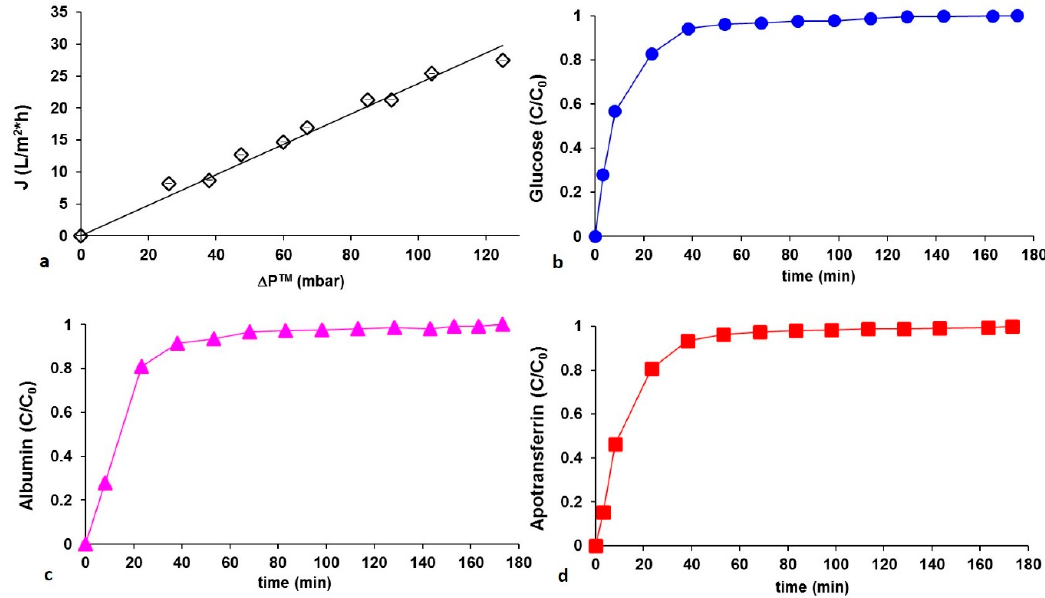
Figure 3. ( a ) Hydraulic permeation measurements of PCL HF membranes at different transmembrane pressures ∆ P ™ . Experimental values were averaged on 10 measurements; the interpolation of experimental data is reported as a solid line: slope (hydraulic permeance): 0.238 L / m 2 · h mbar; R-squared value: 0.98. Concentration appearance profiles of ( b ) glucose, ( c ) albumin, and ( d ) apotransferrin permeating PCL HF membranes at constant transmembrane pressure ∆ P ™ 40 mbar.